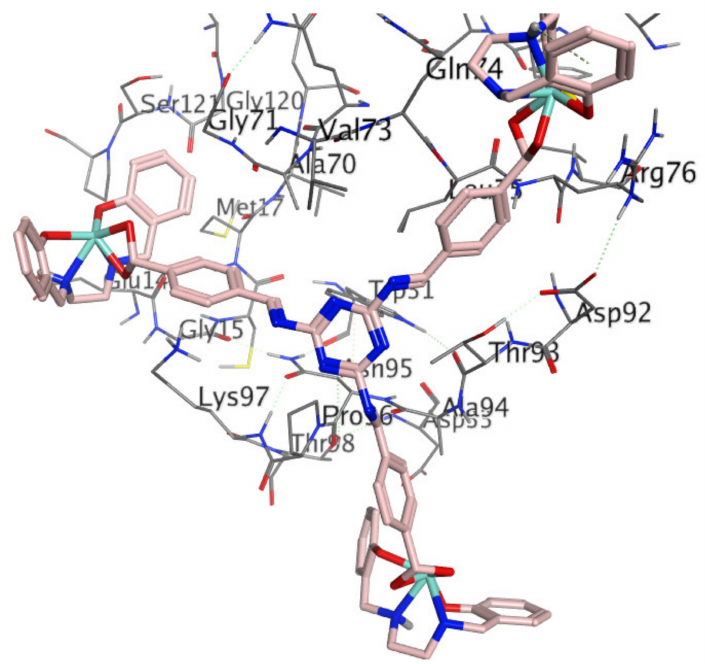
Figure 3. Binding pose of Er(III)MT in the active binding site of 6Y84.